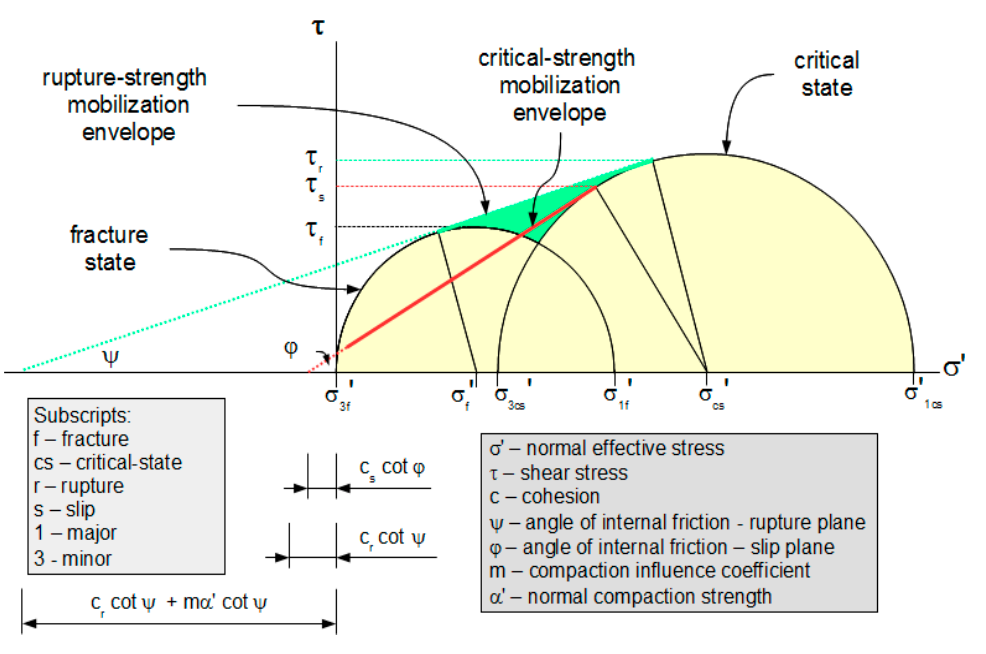
Figure 7. Rupture strength and critical strength at critical state.